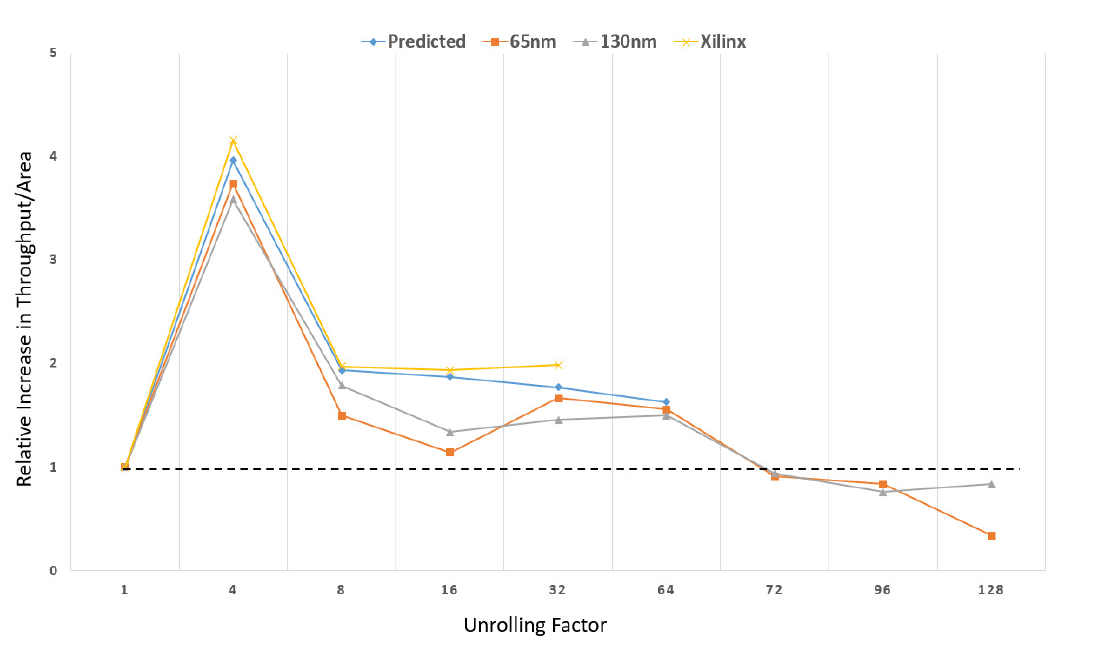
Figure 5. Relative increase in throughput/area vs. unrolling factor: